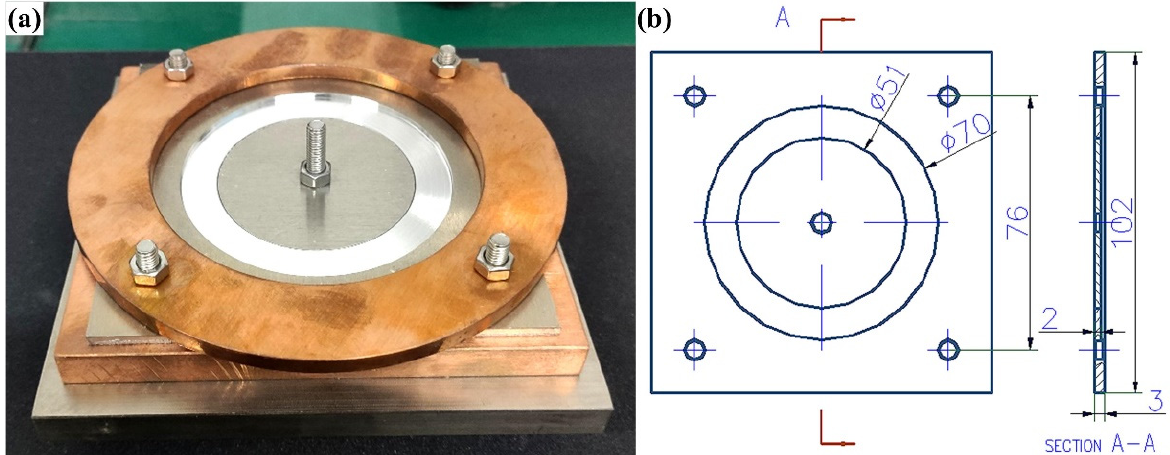
Figure 1. Circular-patch welding experiment: ( a ) Assembly of the parts; ( b ) dimensions of the workpiece (unit: mm).